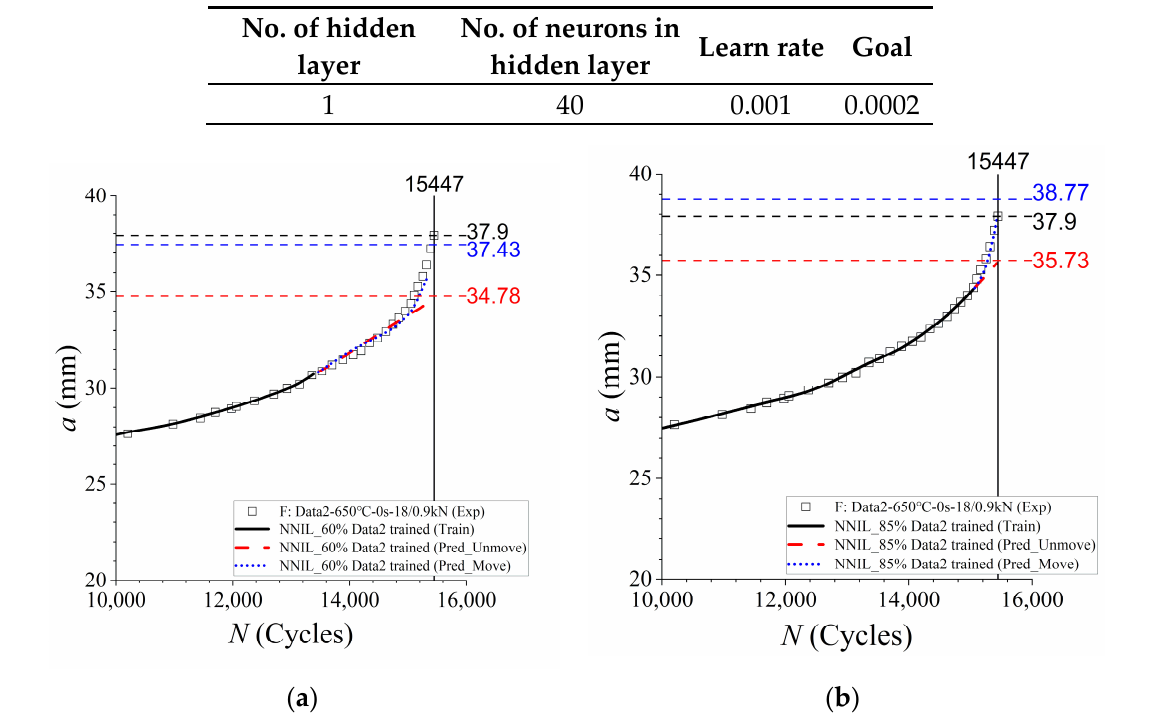
Figure 13. a - N curves prediction using NNIL scheme by moving/unmoving basic data with (a) 60% and (b) 85% data as the train dataset.